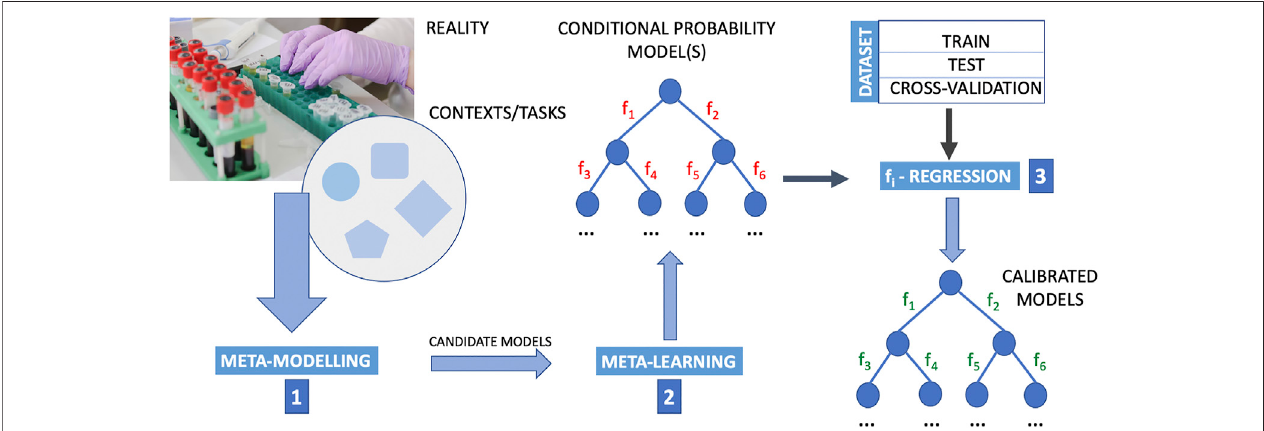
FIGURE 1 | Outline of a computational procedure using upstream meta-modelling for the inference of causal structures. Meta-learning into a composite upside- down framework that includes the following phases in the following order. Step 1: meta-modelling fi rst provide candidate models; step 2: meta-learning is designed to learn from data the conditional probability structure of these models where the structure and parameters of mathematical relations de fi ning the interaction between nodes (i.e., the functions f i , i = 1, 2, ... , M with M the number of arcs in the probability graph) are then determined by regression methods (step 3). By employing meta-modelling upstream to meta-learning, and meta-learning it-self in place of a direct application of machine-learning, this pipeline extends a typical machine learning approachthatgenerallyposestheproblemofstructuralcausaldiscovery asaproblemoflearningthefunctions f i .Inthispipeline,thedeterminationofoptimal f i functions is posed as a regression problem once meta-modelling and meta-learning has identi fi ed wiring diagrams. The data are essential to the learning and regression procedure. The data are typically divided into train set, test set and cross-validation set. Cross-validation is a resampling procedure used to assess machine learning modelsonalimiteddatasample,andforthesakeofsimplicityinthis fi gureisreportedasasubsetofthedataset.However,theprocedurehasasingleparametercalled K that refers to the number of groups that a given data sample is to be split into (for this reason for “ cross-validation ” it is usually meant K-fold cross-validation.). In K-fold crossvalidationwehavemultiple(K)train-testsetsinsteadof1,sothatwetrainandtestthemodelK-times.Thepurposeofdoingthisisthatinasingletrain-testsplit,the